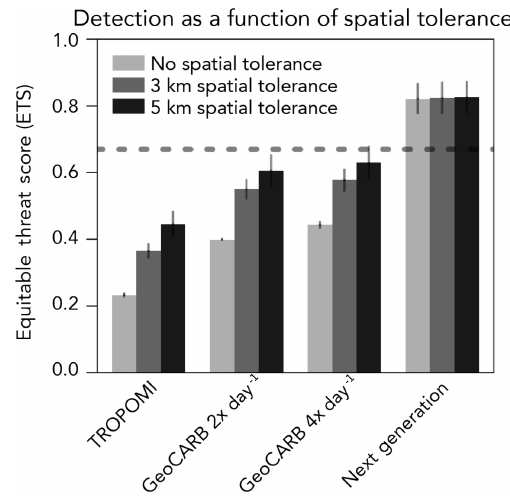
Figure 8. Effect of introducing spatial tolerance in the detection of high-mode emitters. Spatial tolerance is the radius within which a high-mode emitter must be located in order for a prediction to be called true positive (TP). The results are for an emission field with 100 production sites in the 50 × 50km 2 domain. Only results from the L 1 inversion method are shown. The dashed line represents the ETS success criterion.